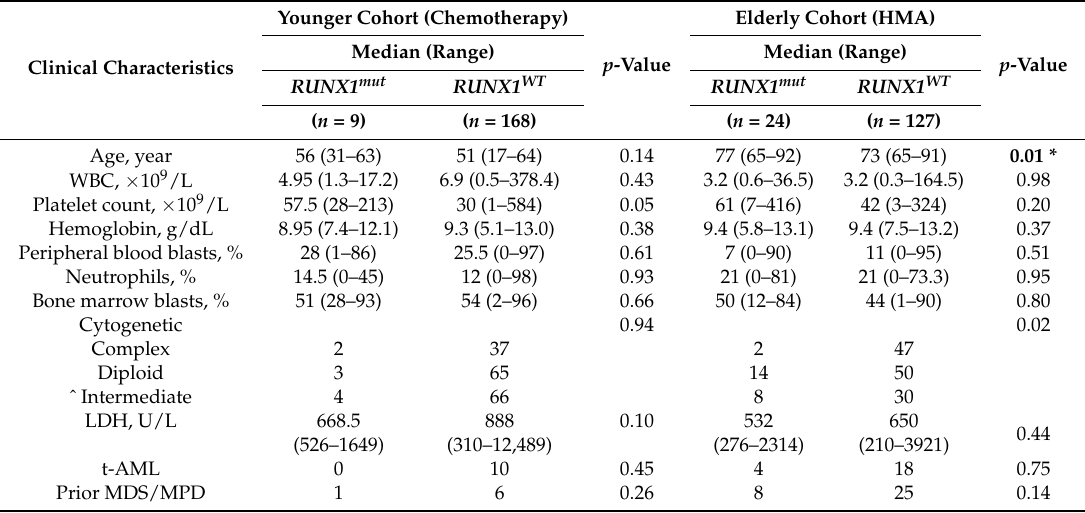
Table 1. Clinical characteristics in the younger cohort receiving chemotherapy and the elderly cohort receiving hypomethylating agents according to RUNX1 mutation